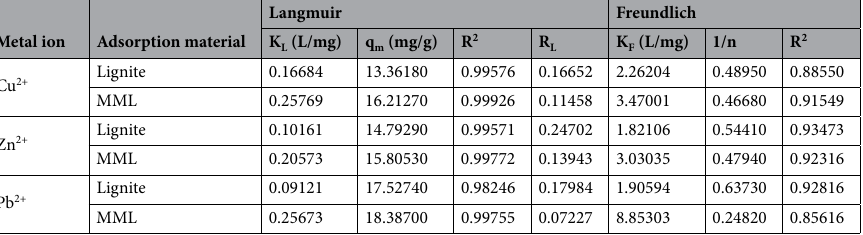
Table 1. Adsorption isotherm constants for the adsorption of heavy metal ion onto different samples: lignite;